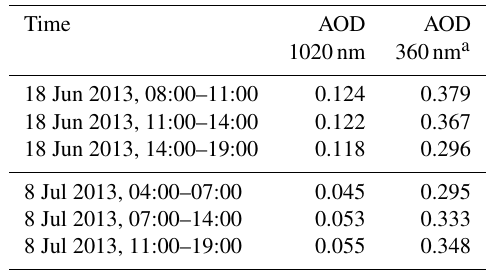
Table A26. Average AOD derived from the sun photometer at 1020 and